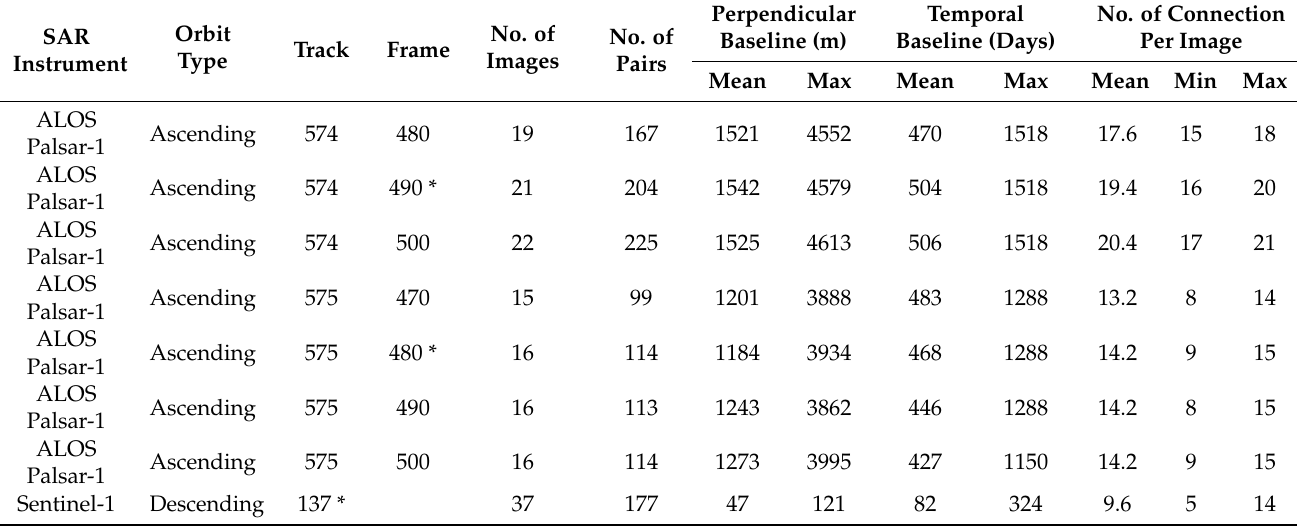
Table 1. Descriptions of the final Small Baseline Subset (SBAS) stacks used in this